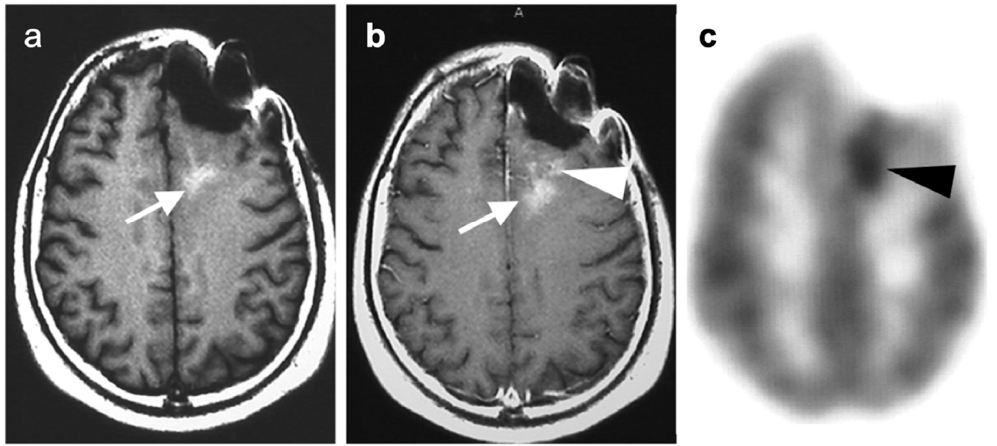
Figure 47. Recurrent high-grade glioma following surgery and radiation. ( a ) T1 non-contrast- enhanced MRI demonstrates a high signal area (white arrow) that does not enhance and is consistent with a region of gliosis. ( b ) Gd enhanced T1 MRI shows enhancement of a nodular region anterior to the region of gliosis, at the margin of the resection cavity (white arrowhead). ( c ) Axial FDG PET image shows that the enhancing region on MRI demonstrates prominent metabolic activity, consistent with recurrent glioma (black arrowhead).